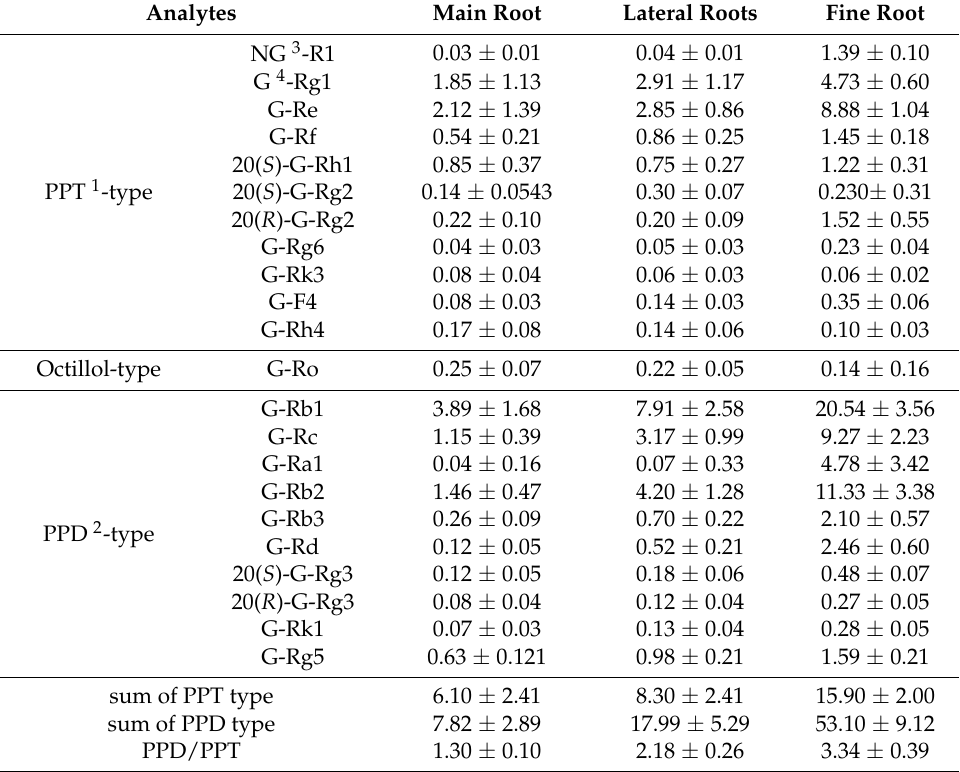
Table 2. Ginsenoside content for the three components of red ginseng (RG) ( n = 20 mg/g).